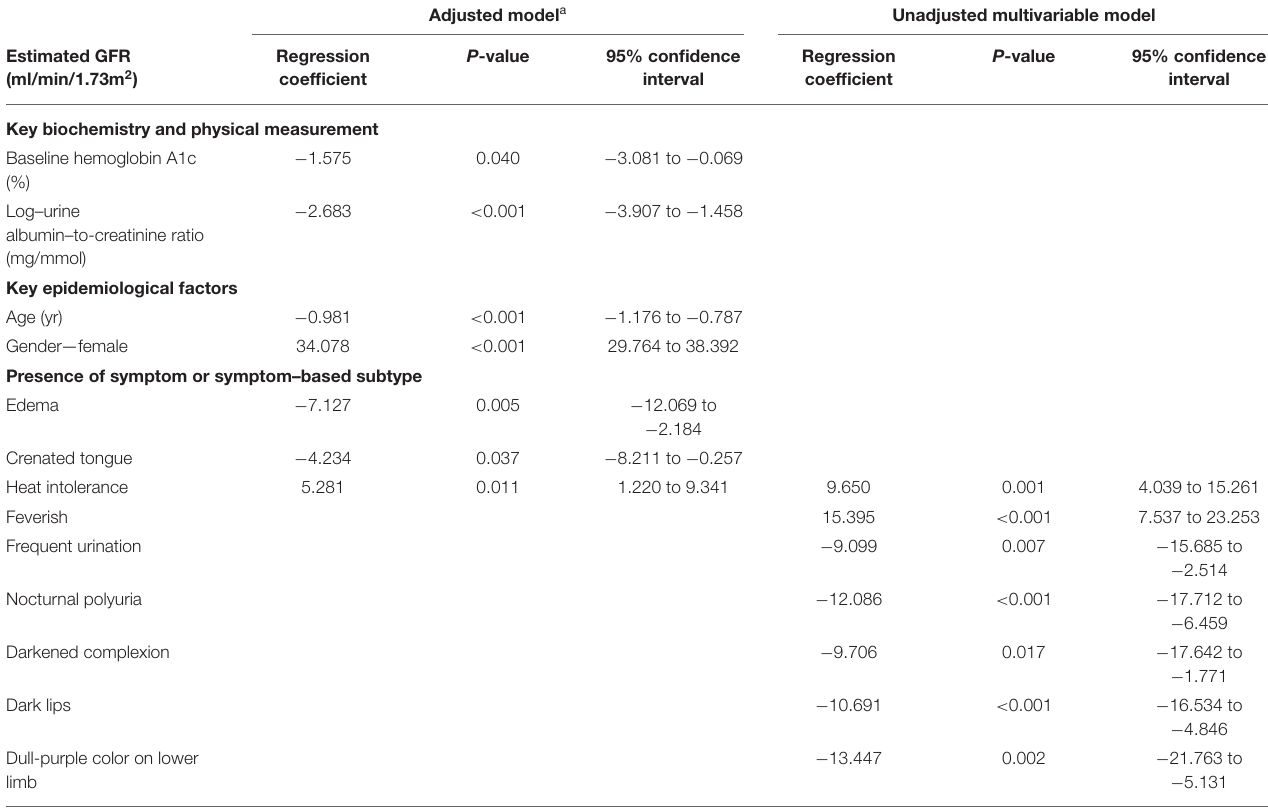
TABLE 3 | Cross-sectional association between glomerular filtration rate and symptoms at baseline. Adjusted model